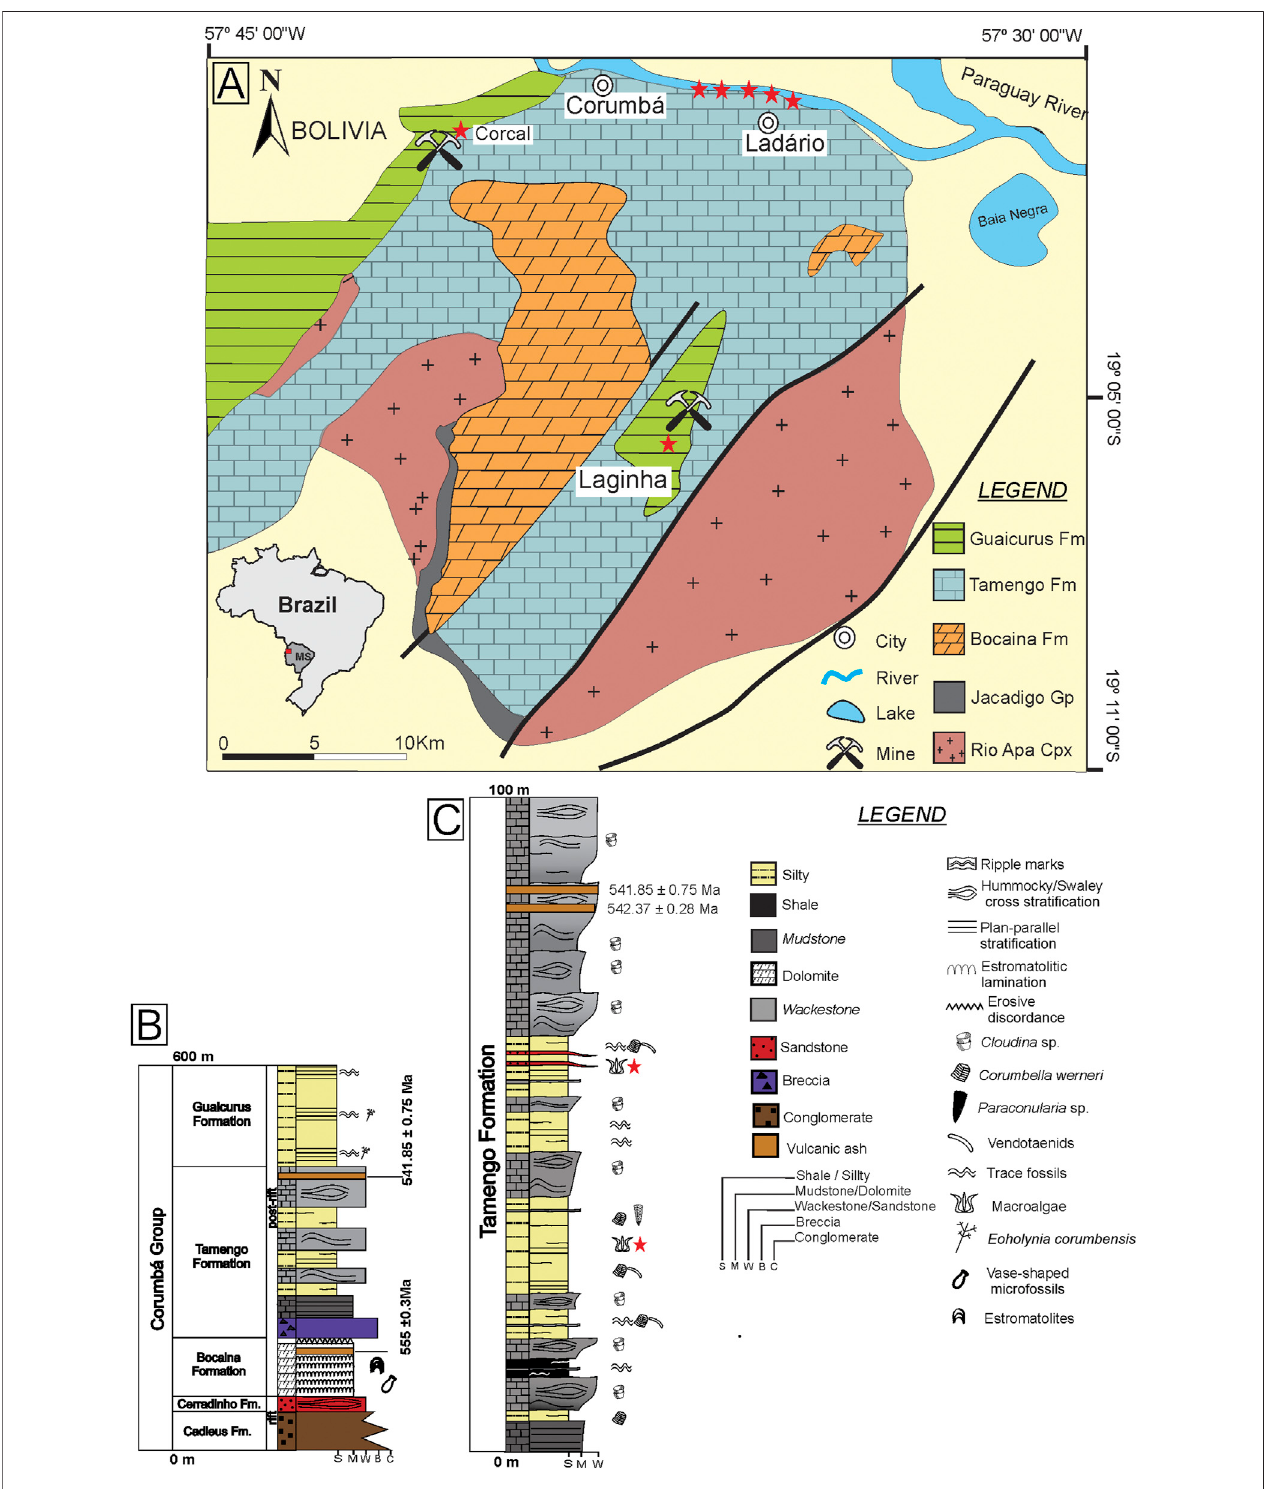
FIGURE 1 | Geological setting of the study area (modi fi ed from Amorim et al., 2020). (A) Stars represent the sites where the outcrop is exposed and studied. (B) StratigraphiccolumnoftheCorumbáGroup(modi fi edfromParryetal.,2017). (C) CondensedsectionoftheTamengoFormation,inLadário,PortoSobramil,andCorcal Mine.